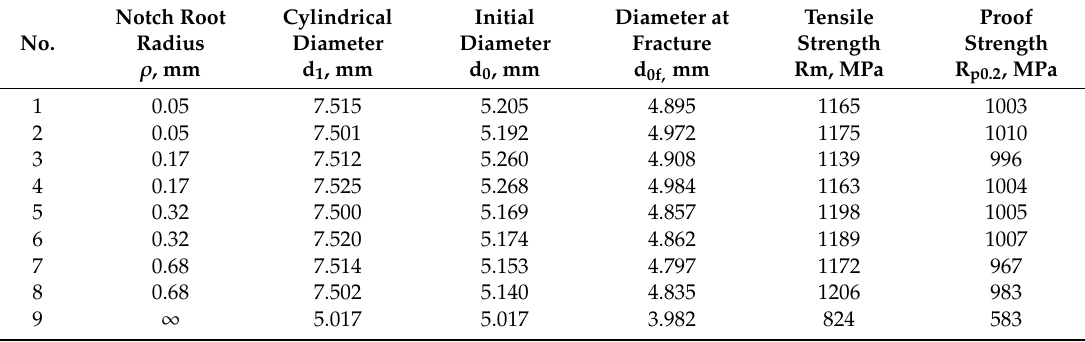
Table A2. Tensile test results on stress-relieved